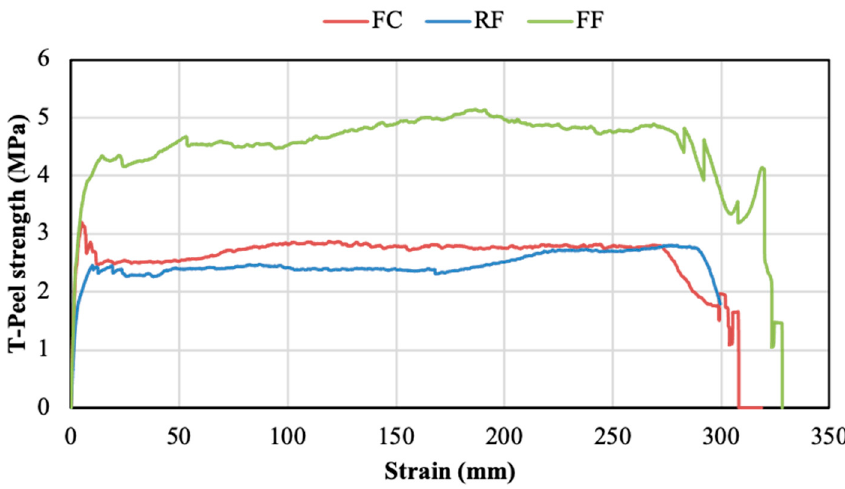
Figure 14. Characteristic T-peel stress–elongation curves of the 3 PSAs.